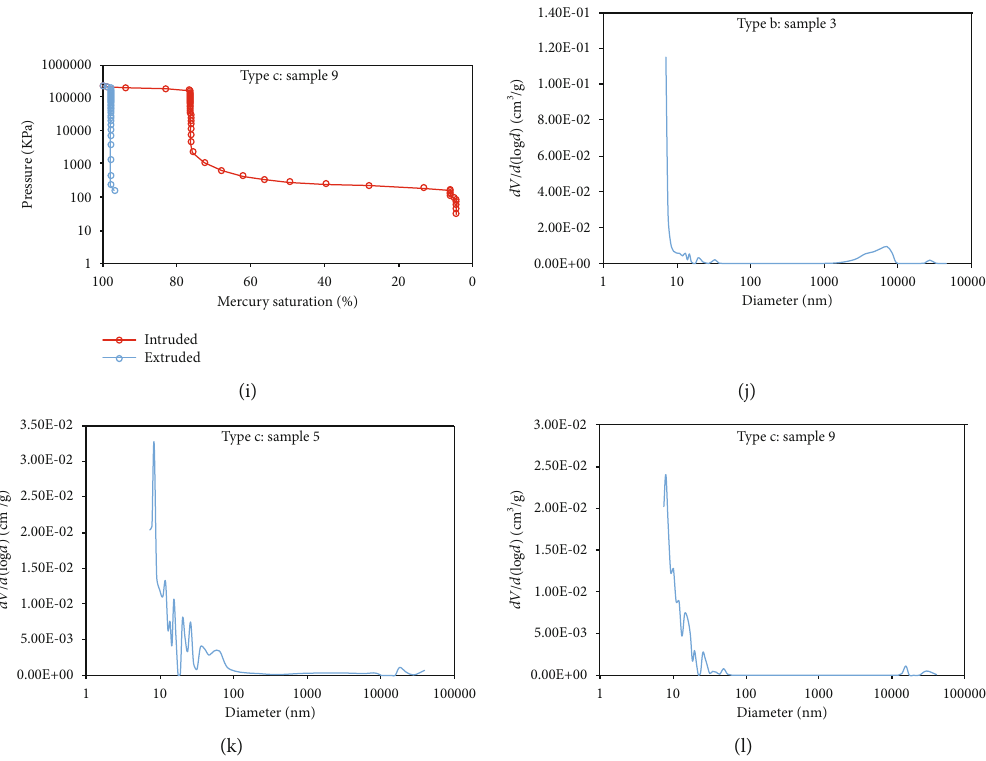
Figure 8: Mercury saturation versus mercury injection pressure of three types of shales in K distributions of shale samples for K